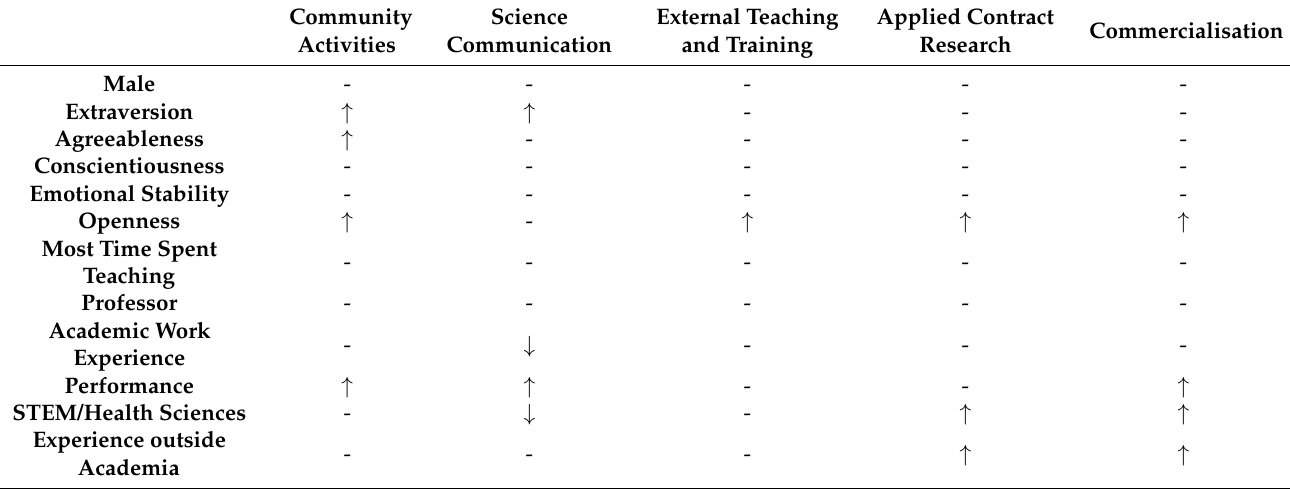
Table 6. Individual and organisational factors influencing different types of TM